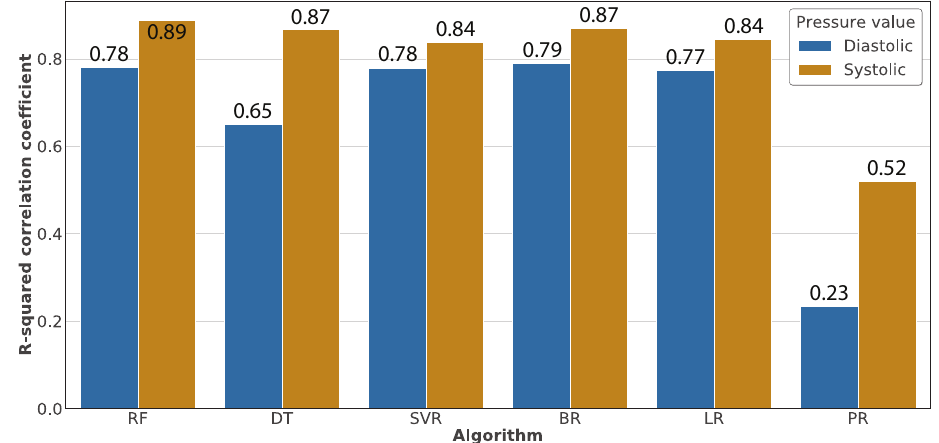
Figure 13. R-squared correlation coefficient for real-time predictions.